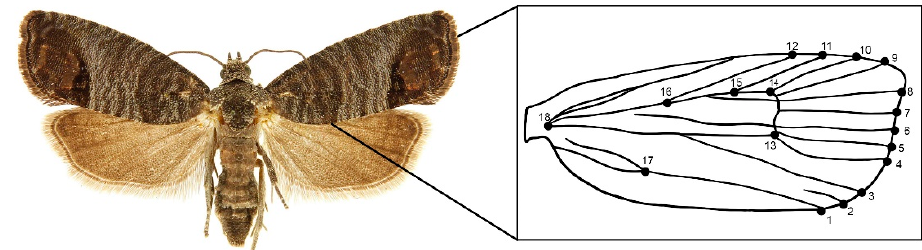
Figure 2. Position of 18 landmarks type 1 on a Codling moth forewing (adapted with permission from Ref. [57]. 2019, Paja č Živkovi ć , I.).